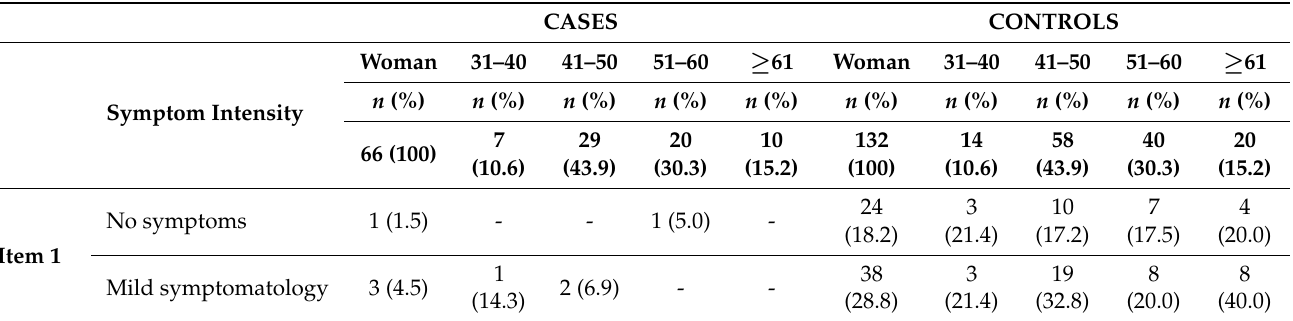
Table A1. Frequencies of the scores assigned to each item of Scale 3 of the QEESI questionnaire in